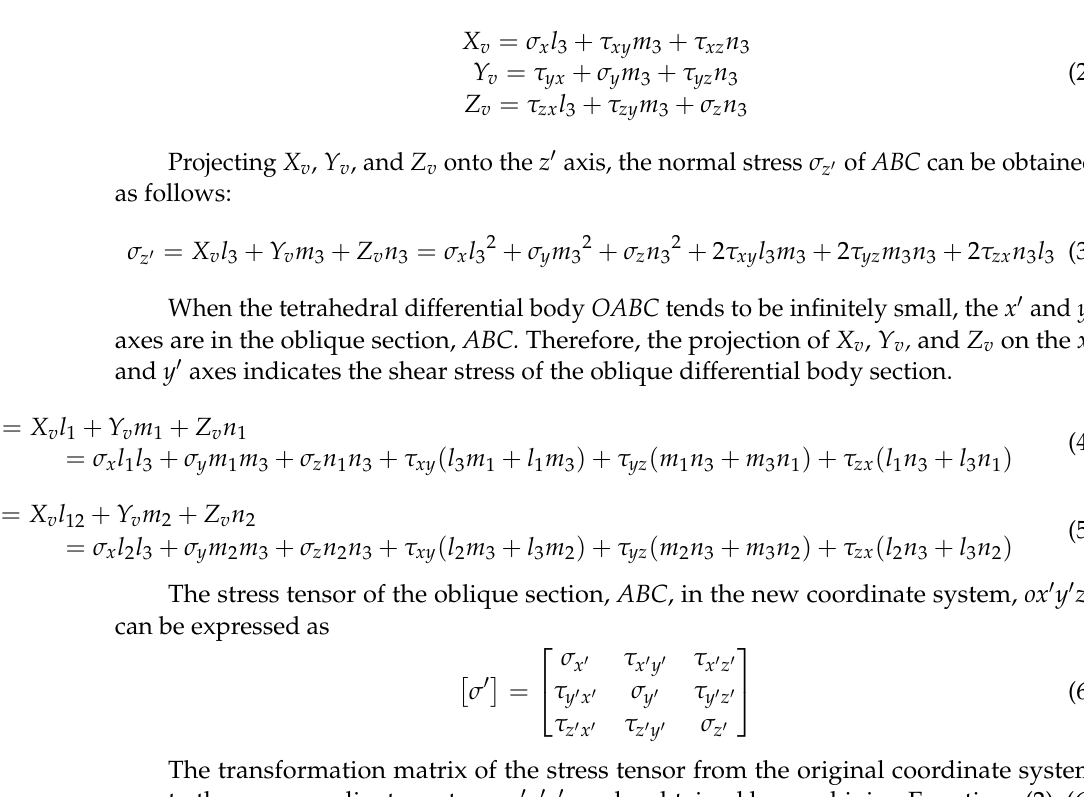
The transformation matrix of the stress tensor from the original coordinate system oxyz to the new coordinate system ox (cid:48) y (cid:48) z (cid:48) can be obtained by combining Equations (2)–(6).